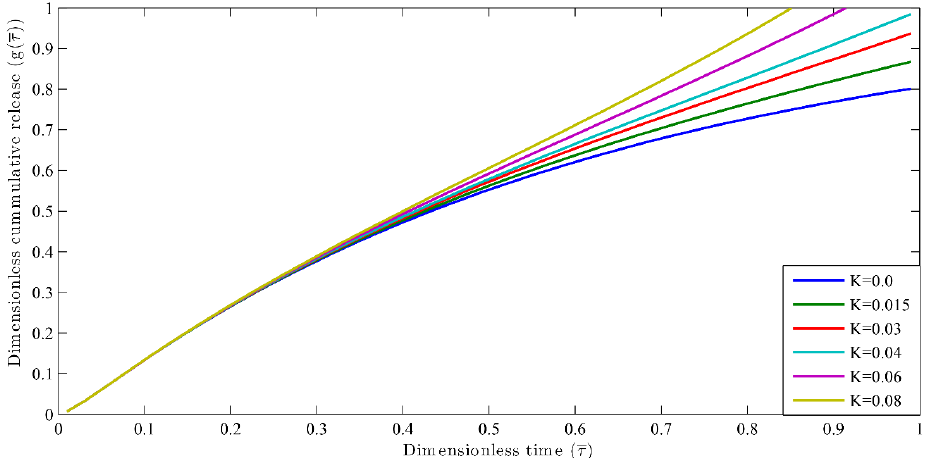
Figure 4. Dimensionless cumulative release versus dimensionless time for different reaction constants at 𝑉 𝑟 = 10 .